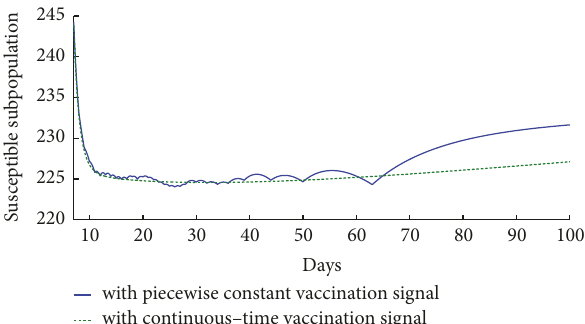
Figure 15: Vaccinated subpopulation in the SISV model with two different vaccination signals: (i) piecewise constant signal taking integer values and (ii) continuous-time signal.